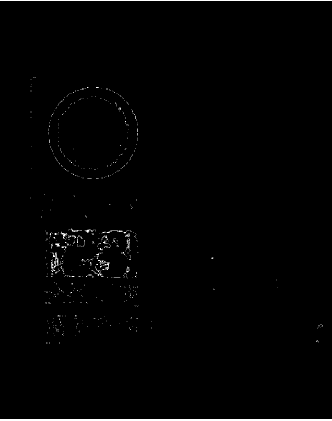
Figure 4. The threshold rough segmentation image.